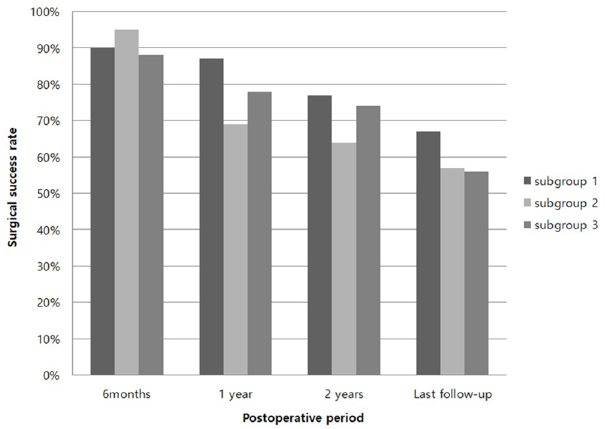
Fig 2. Surgical success rate in group O (4–16 years old). � p < 0.05, Statistically significant (Pearson’s chi-square test). Group Y: patients under 4 years of age, Group O: patients between 4 and 16 years of age Subgroup I: postoperative 1 week esophoria-tropia (ET) � 10 prism diopters (PD), Subgroup II: postoperative 1 week ET 1-9 PD, Subgroup III: postoperative 1 week orthotropia or exophoria-tropia (XT).